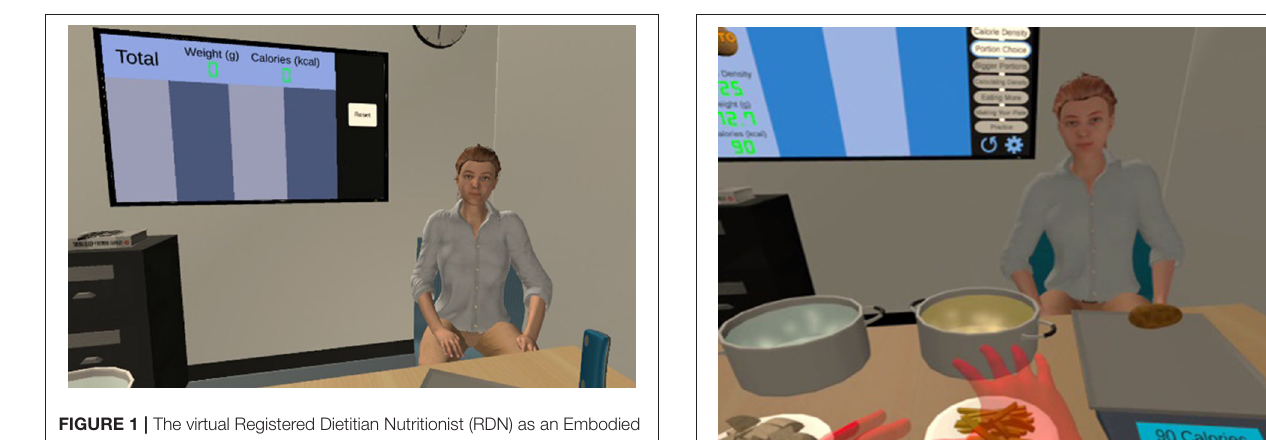
FIGURE 1 | The virtual Registered Dietitian Nutritionist (RDN) as an Embodied Conversational Agent.